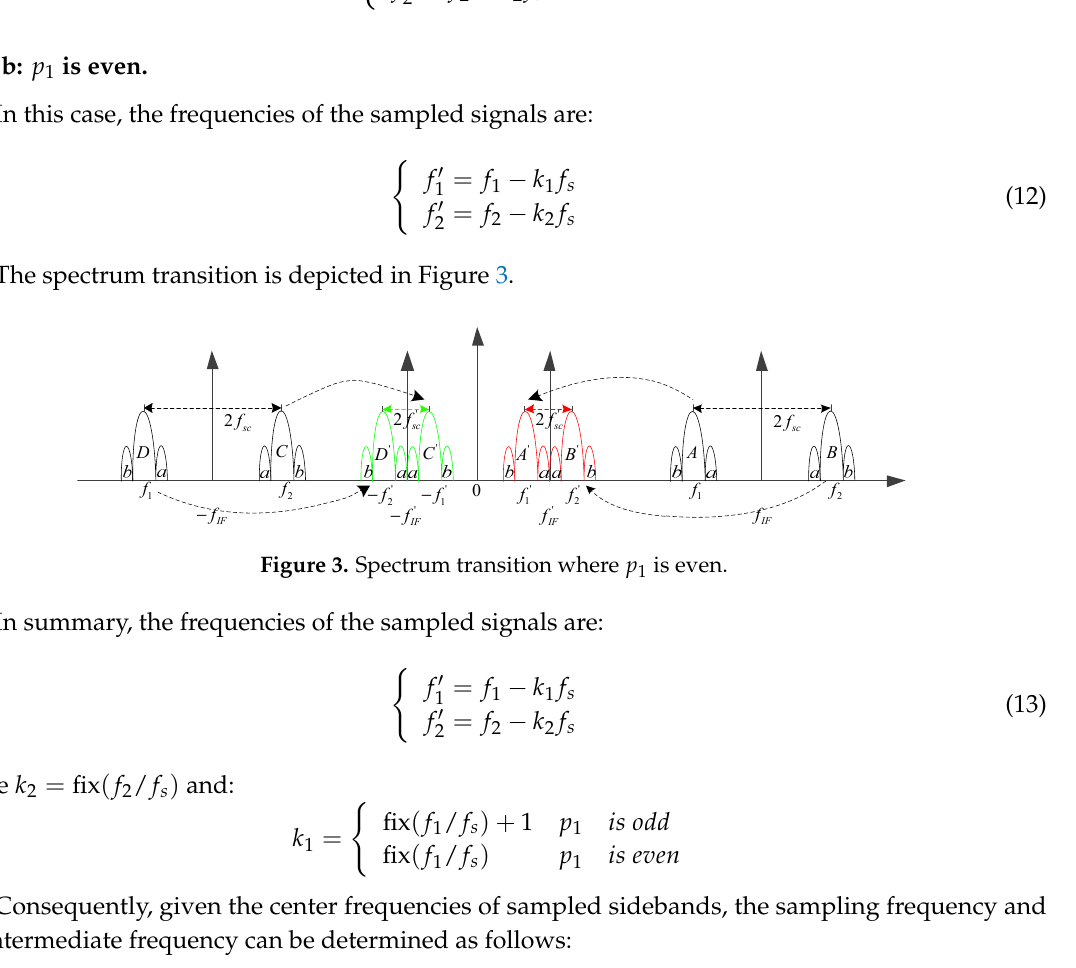
Figure 2. Spectrum transition where